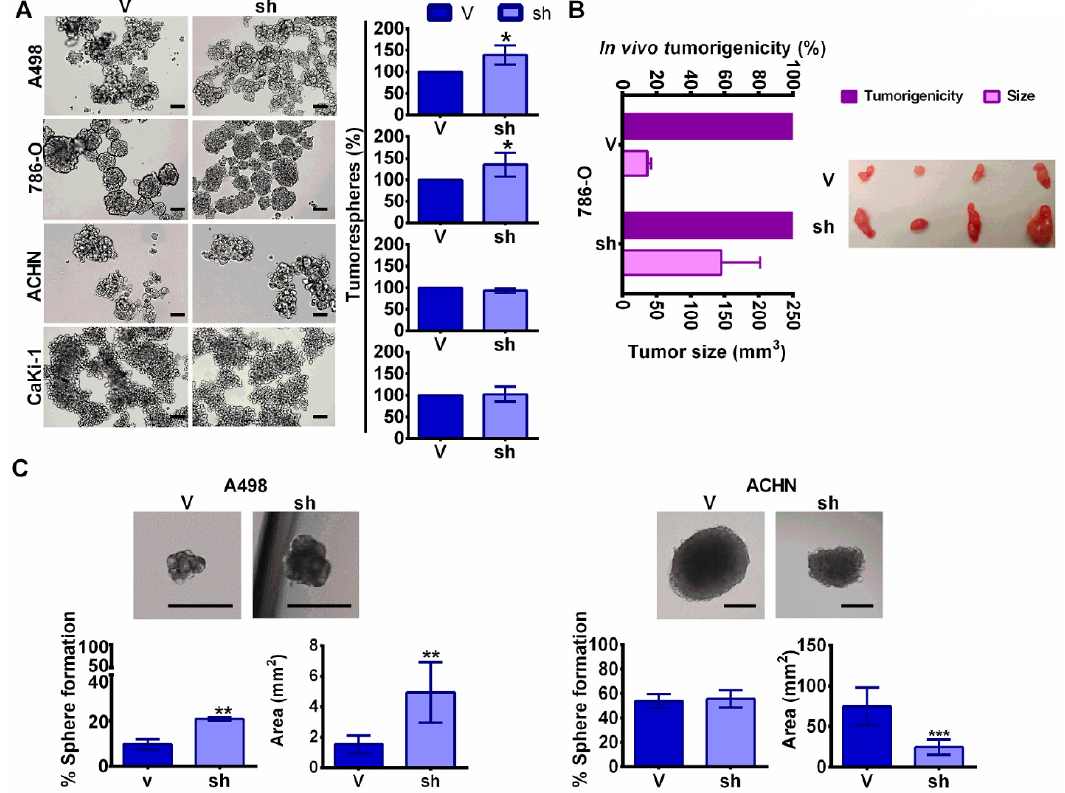
Figure 3. MYBBP1A knock down in c-MYB + cell lines induce cancer stem properties. ( A ) MYBBP1A knock down increases the number of tumorspheres in A498 and 786-O cell lines. Graphs represent the percentage of tumorspheres in MYBBP1A knock down cells compared to control cells. Scale bars: 200 µ m. ( B ) Tumorigenicity of tumorspheres in vivo. Tumorspheres from 786-O cells expressing the scramble vector (V) or shMYBBP1A (sh) were injected in nude mice. Graph shows the percentage of tumors formed and the mean ± SD of the tumor size at day 50. n = 4. ( C ) Tumorsphere formation from one isolated cell. Graphs show the mean ± SD of the percentage of sphere formation and sphere area. Scale bars: 250 µm * p < 0.05; ** p < 0.01; *** p < 0.001.